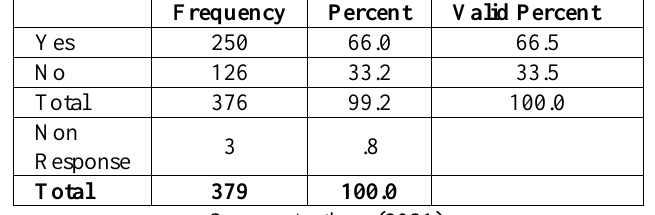
Table 6: Willingness to go to work using public transport.